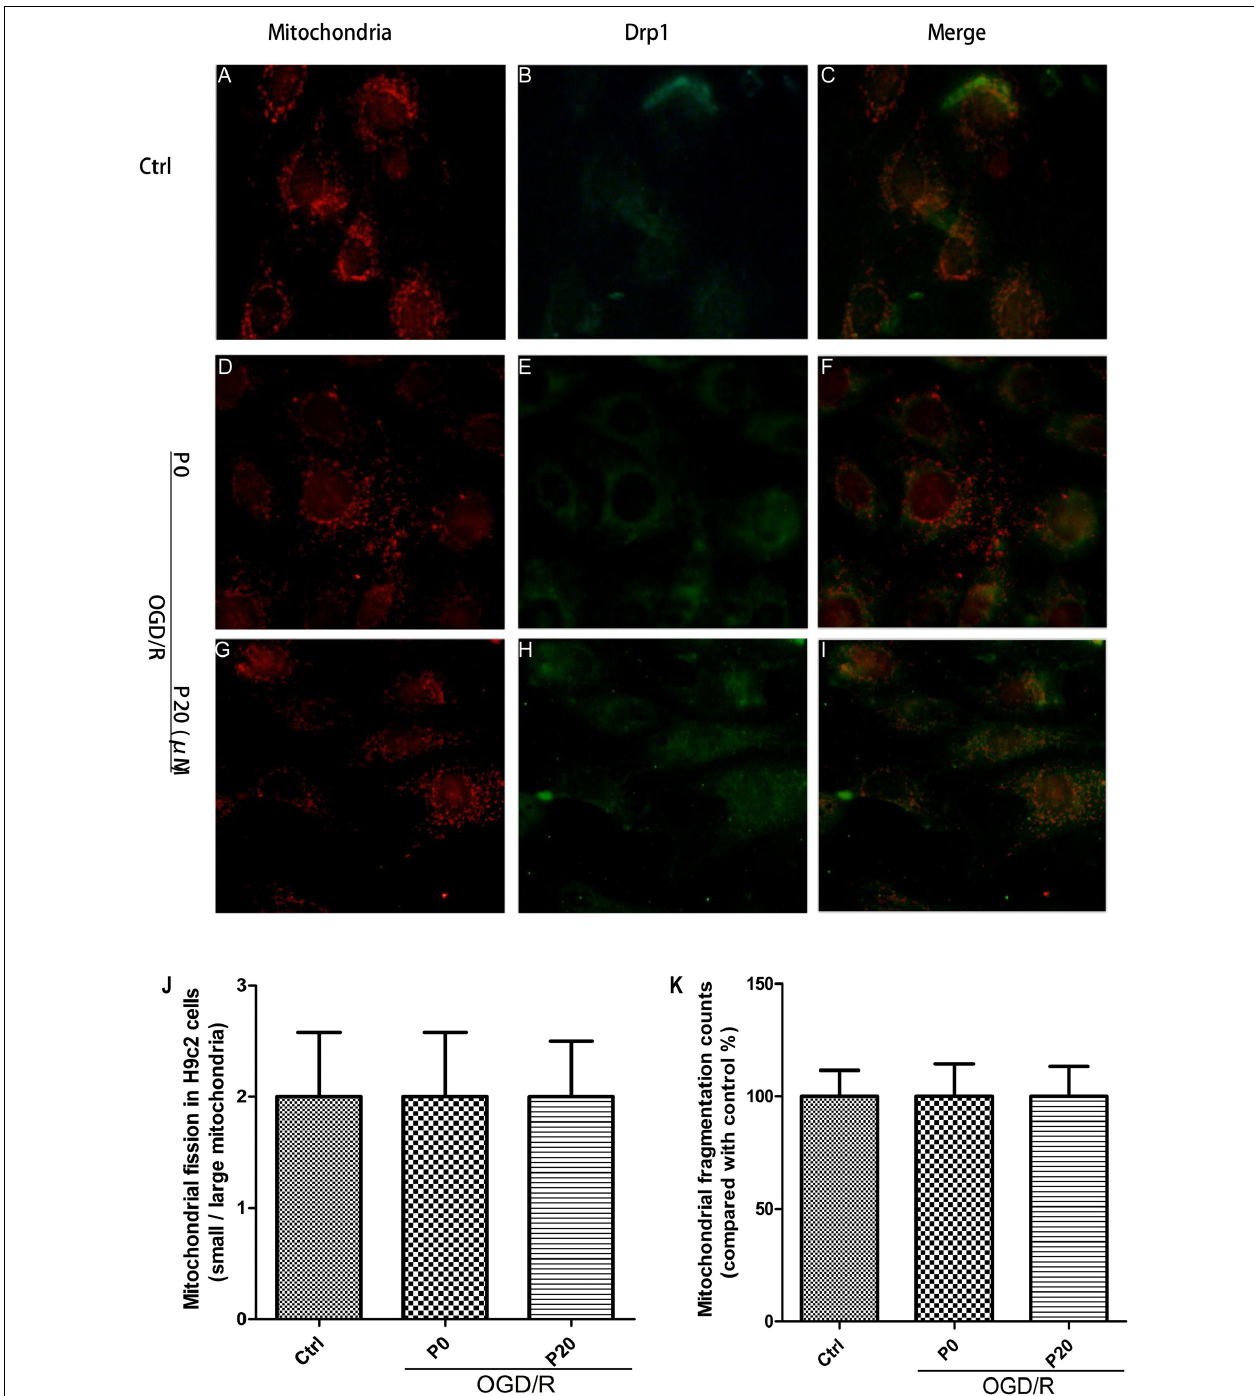
FIGURE 5 | Mitochondrial morphology and quantity kept stable and propofol inhibited Drp1 colocalization with mitochondria in H9c2 cells during OGD/R injury. (A,D,G,J,K) Mitochondrial (red) morphology and quantity of H9c2 cells kept stable among control group, OGD/R group without propofol and OGD/R group with 20 µ M propofol. Scale bar: 25 µ m. (B,C) There was a lower fluorescence signal for Drp1 (green) and most Drp1 was collocated with the mitochondria or surrounded them in control group. (E,H) The distribution of Drp1 in OGD/R group with 20 µ M propofol was more diffuse than the distribution of it in OGD/R group without propofol. (F) Plenty of Drp1 was collocated with mitochondria or surrounded them in OGD/R group without propofol. (I) Using 20 µ M propofol treatment, Drp1 (green) was significantly prevented from cytoplasm to mitochondria during OGD/R injury. The data are presented as the mean ± SD of at least three independent